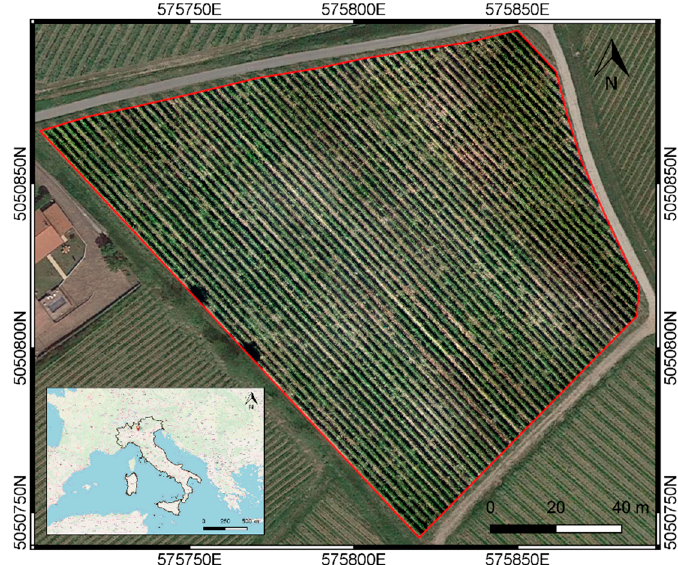
Figure 1. The experimental site; Coordinate Reference System (CRS): WGS84/UTM zone 32 N. Map data: ©OpenStreetMap contributors.